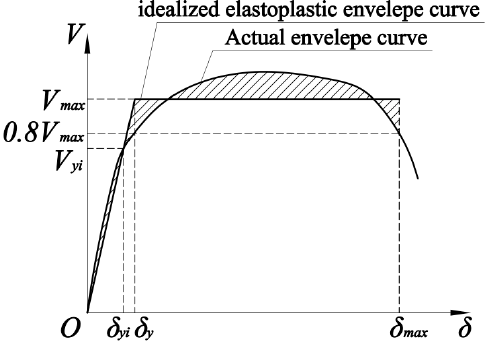
Figure 10. Definition of the idealized elastoplastic envelope Figure 10. De fi nition of the idealized elastoplastic envelope curve.